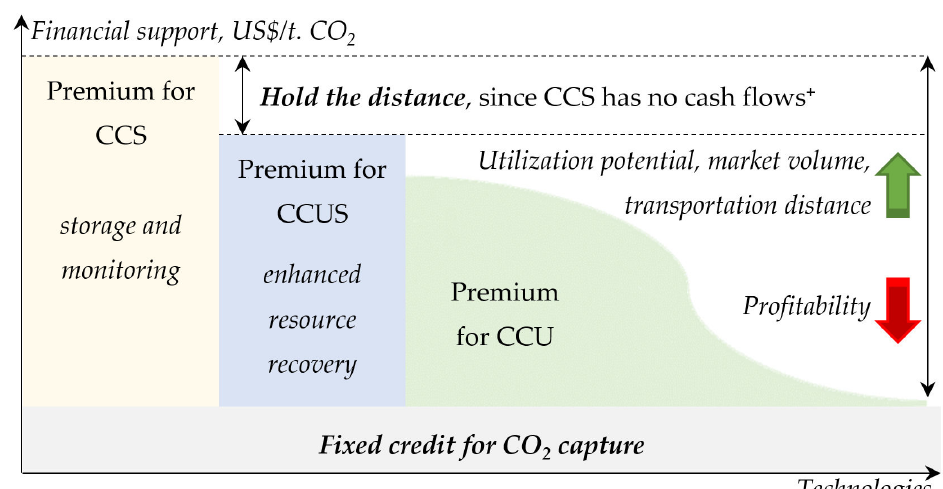
Figure 8. Framework for extending 45Q support